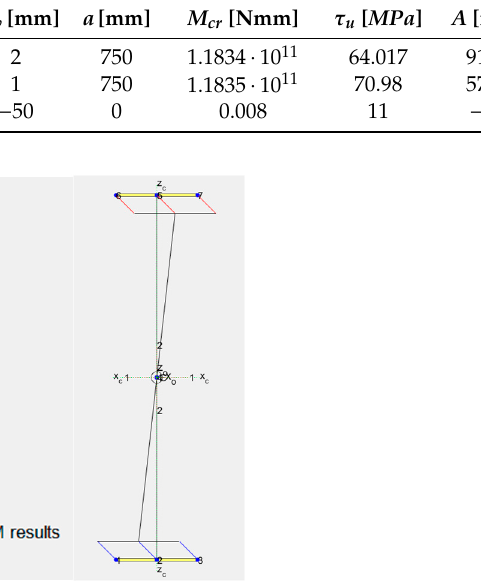
Figure 6. Results of the analysis with finite strip method using the software package CUFSM for the slender web.